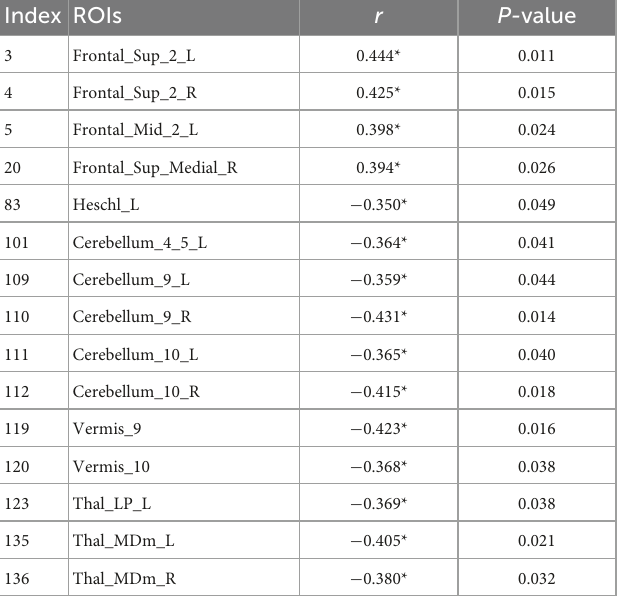
TABLE 2 Region of interests (ROIs) where DC values correlate with uric acid (UA) values.